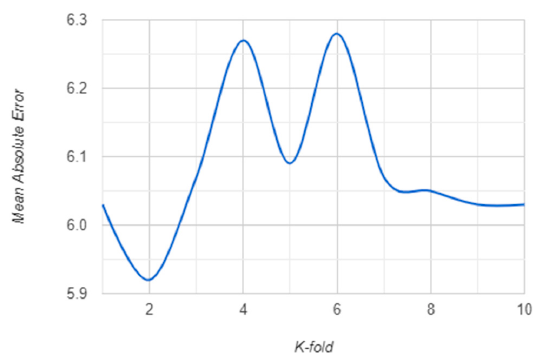
Figure 9. MAE for 10-fold cross-validation of the RF model.